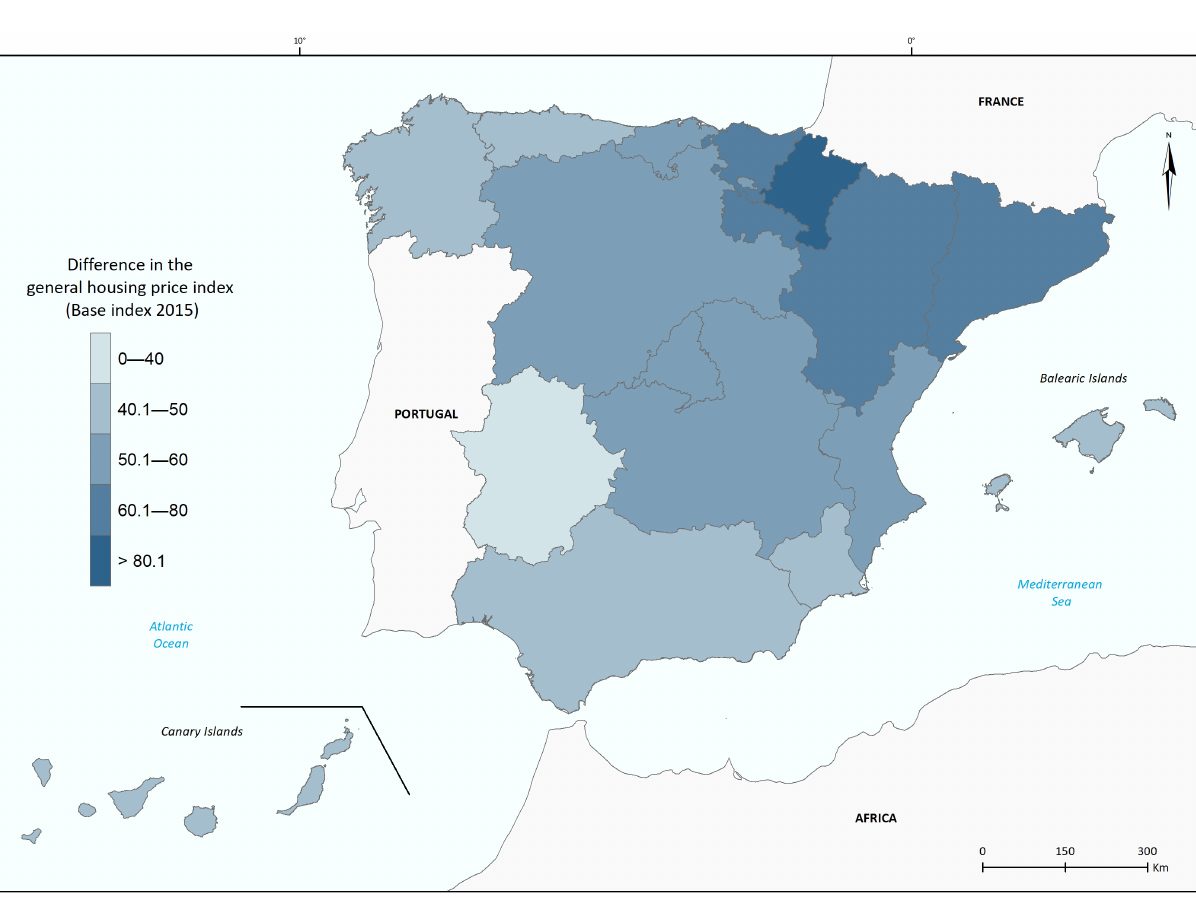
Figure 4. Difference in the general housing price index (Base index 2015) (20081Q–20141Q). Source: Housing Price Index (HPI), National Statistics Institute, Spain (INE) [27]. Author’s